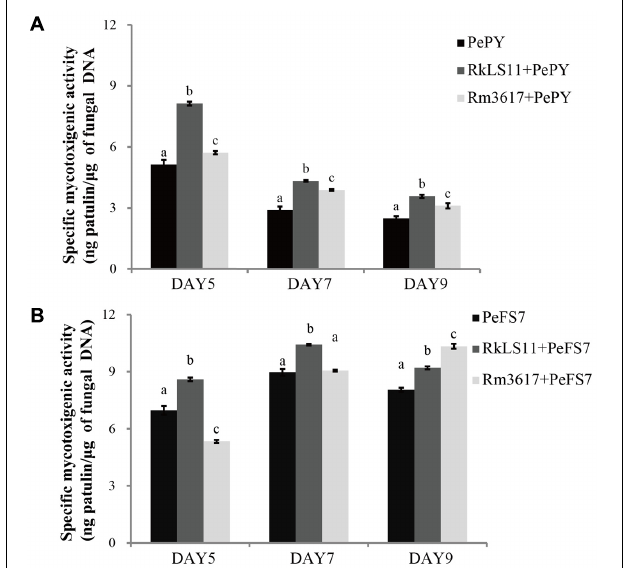
FIGURE 6 | Time course of specific mycotoxigenic activity (ng patulin/ µ g of fungal DNA) of strains PY (A) and FS7 (B) of Penicillium expansum in infected apples, in the presence and in the absence of the biocontrol yeasts Rhodotorula mucilaginosa strain 3617 and R. kratochvilovae strain LS11. (A) Decay incidence caused by Penicillium expansum strain PY. (B) Decay incidence caused by P. expansum strain FS7 on apples. PePY, P. expansum strain PY; PeFS7, P. expansum strain PeFS7; Rm3617, Rhodotorula mucilaginosa strain 3617; RkLS11, R. kratochvilovae strain LS11. Bars represent the mean values from two experiments ± standard deviations. Values marked with different letters are significantly different ( P < 0.05).